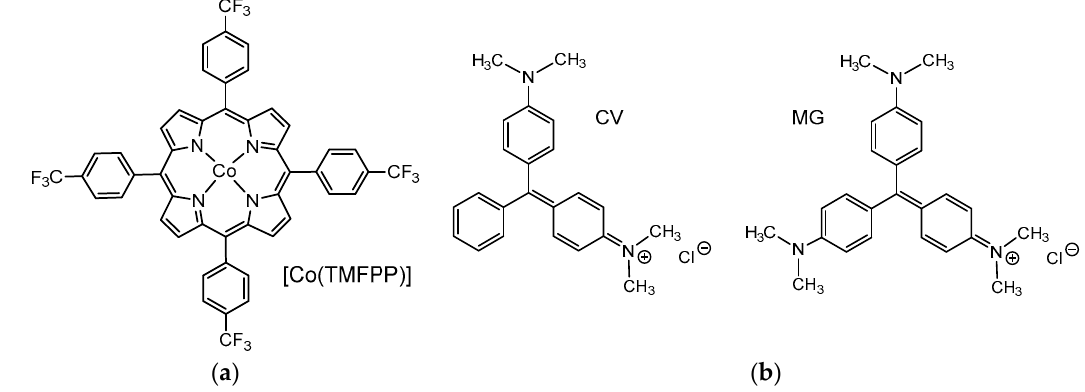
Scheme 1. Structures of [Co(TMFPP)], crystal violet (CV) and malachite green (MG).